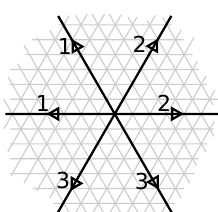
Figure 36 . The WKB foliations when C = C and φ 1 = 0 , φ 2 = 0 , φ 3 = i d z 3 . The leaves passing through z = 0 are highlighted in